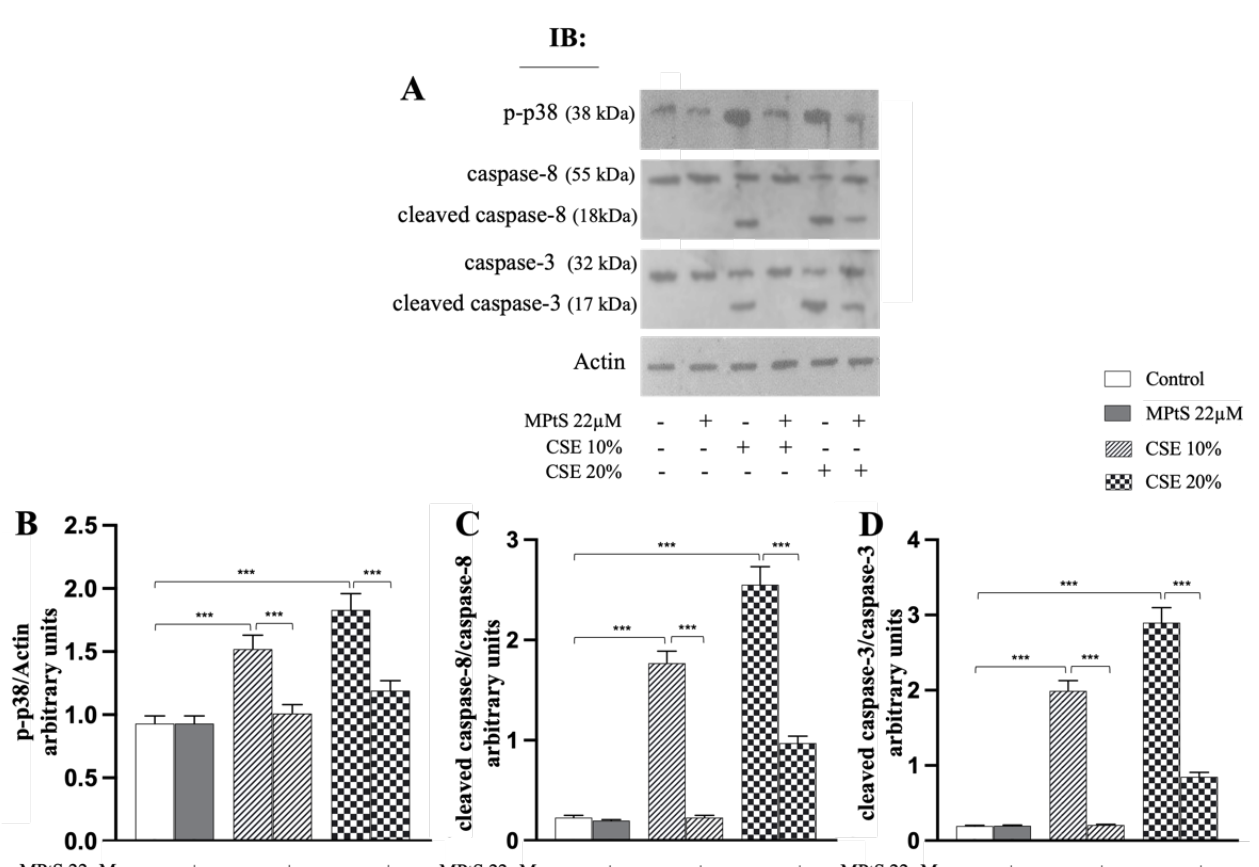
Figure 5. Mixture of plant sterols (MPtS) inhibits caspase 8/caspase 3 cleavage and phosphorylation of p38 MAPK in cigarette smoke extract (CSE)-induced eryptosis. ( A ) Representative images of immunoblotting analysis of p-p38 MAPK, cleaved caspase 8 and cleaved caspase 3 in 10% or 20% CSE-treated RBCs incubated for 4 h in absence or in co-treatment with 22 µ M MPtS. Protocol of analysis at Section 4.7. ( B – D ) densitometric analysis of p-p38 MAPK, cleaved caspase 8 and cleaved caspase 3 levels normalized for actin. For ( C , D ), values are the ratio between cleaved and uncleaved caspases. Values are the means of bands’ densitometry of three separate experiments with comparable results carried out on the same blood sample. *** p < 0.001 (ANOVA associated with Tukey’s test).